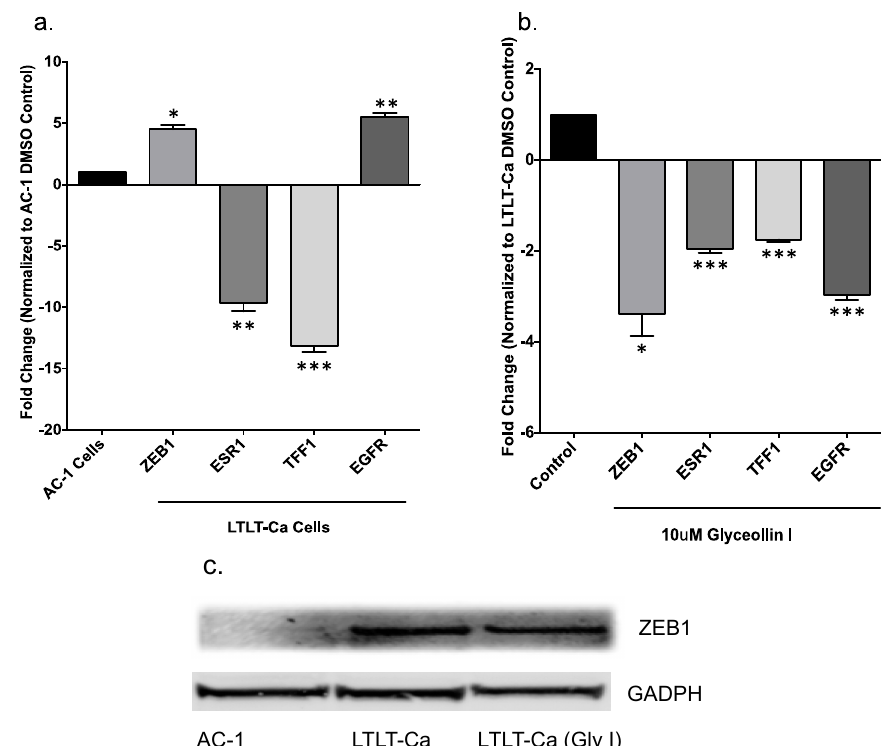
Figure 3. Glyceollin I alters EMT marker expression in LTLT-Ca cells. Total RNA was isolated from ( a ) AC-1 and LTLT-Ca cells or ( b ) LTLT-Ca cells treated with Glyceollin I (10 µ M) and